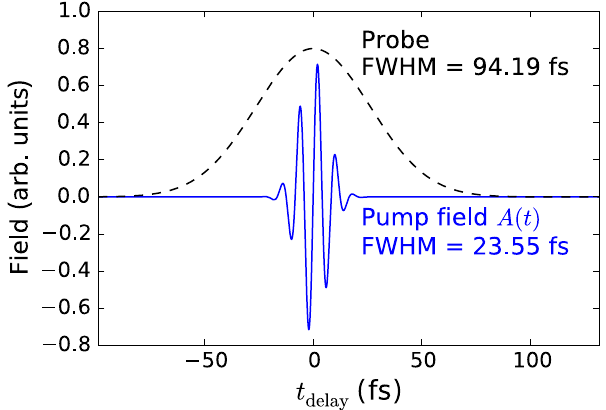
FIG. 2. Pump vector potential A ð t Þ and probe profiles used in this work. The probe profile is the envelope function for the probe